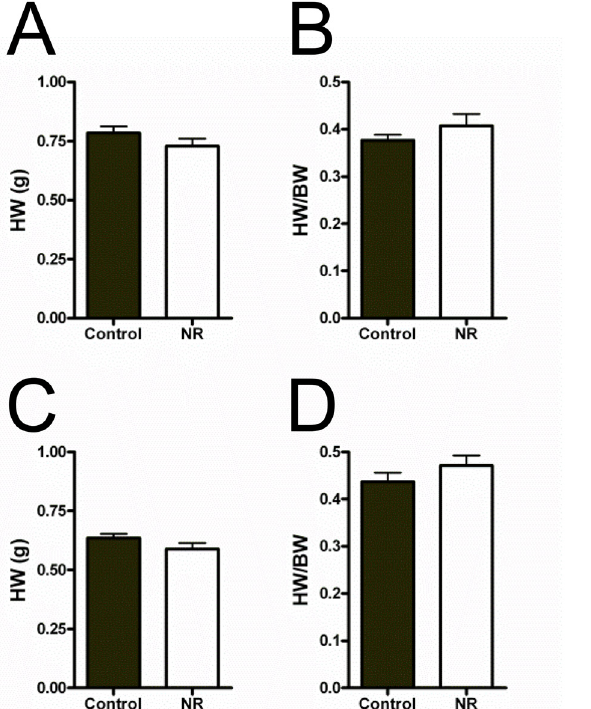
Fig 3. Heart weight and heart weight to bodyweight ratio in control and NR offspring used for physiological experimentation. (A-B) Data for male absolute heart weight and heart weight to bodyweight ratio. (C-D) Female absolute heart weight and heart weight to bodyweight ratio. No significant differences in heart weight, or heart weight to bodyweight ratios were observed in either sex (P > 0.05).